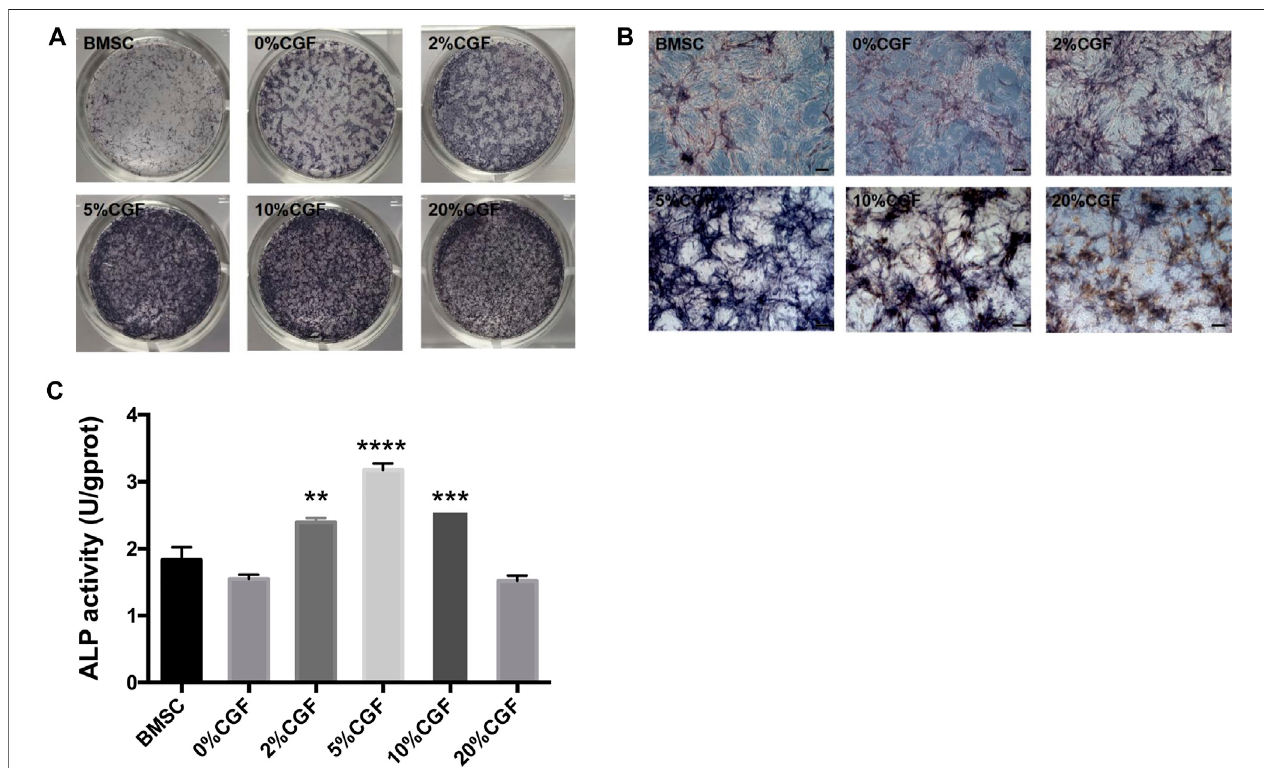
FIGURE 2| Alkaline phosphatase (ALP) staining and its quantitative analysis.ALP staining and activity wasdetected in single cultured hBMSCs group (BMSC) and fi ve directly co-cultured group with different concentrations of CGF (0, 2, 5, 10, and 20%), for 7 days. (A) : General observation. (B) : ALP staining under fl uorescence microscope (ruler: 200 μ m). (C) : ALP quantitative analysis (* p < 0.05, ** p < 0.01, *** p < 0.001, **** p < 0.0001 versus